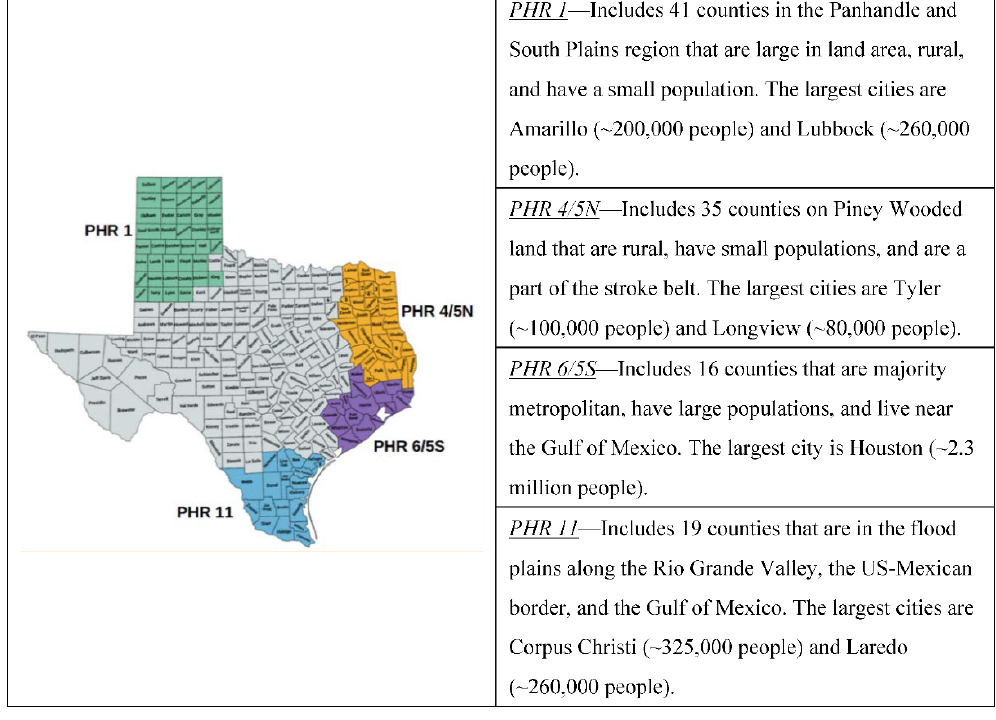
Figure 1. Texas Public Health Regions.